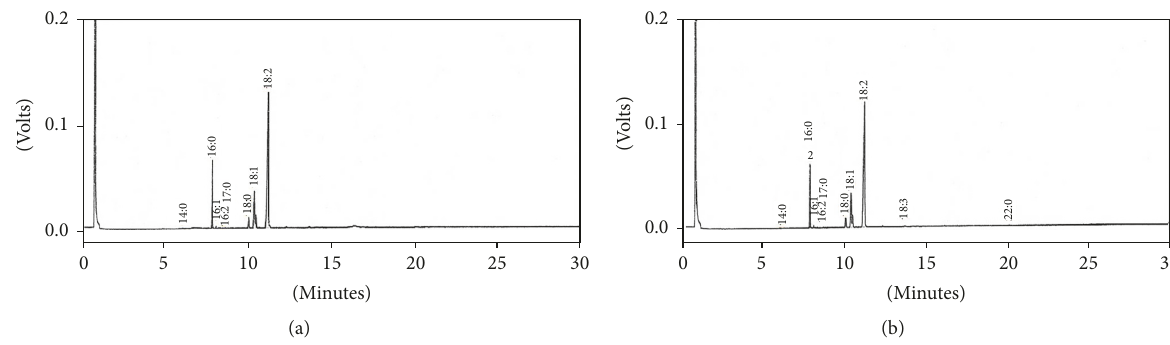
Figure 4: Chromatograms of FAMEs of cactus pear seed oil extract. (a) Green cactus pear seed oil extract; (b) red cactus pear seed oil extract. In both oils extracts were identified: myristic (C14:0), palmitic (C16:0), palmitoleic (C16:1, cis -9), hexadecadienoic (C16:2, cis -9, 12), margaric (C17:0), stearic (C18:0), oleic (C18:1, cis -9), linoleic (C18:2, cis -9, 12), except linolenic (C18:3, cis -6, 9, 12), and behenic (C22:0) fatty acids that were identified only in red cactus pear